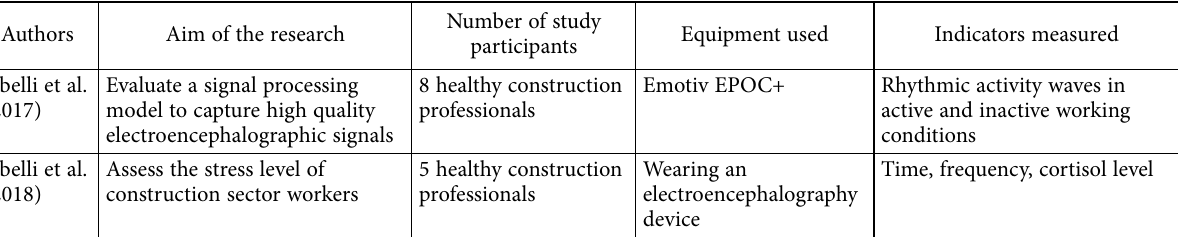
Table 2. Researches employing